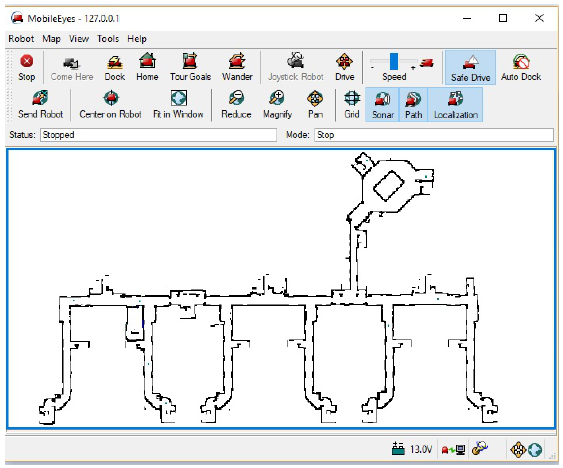
Figure 4. MobileEyes GUI after a successful connection to the server. A logged 2D laser map of